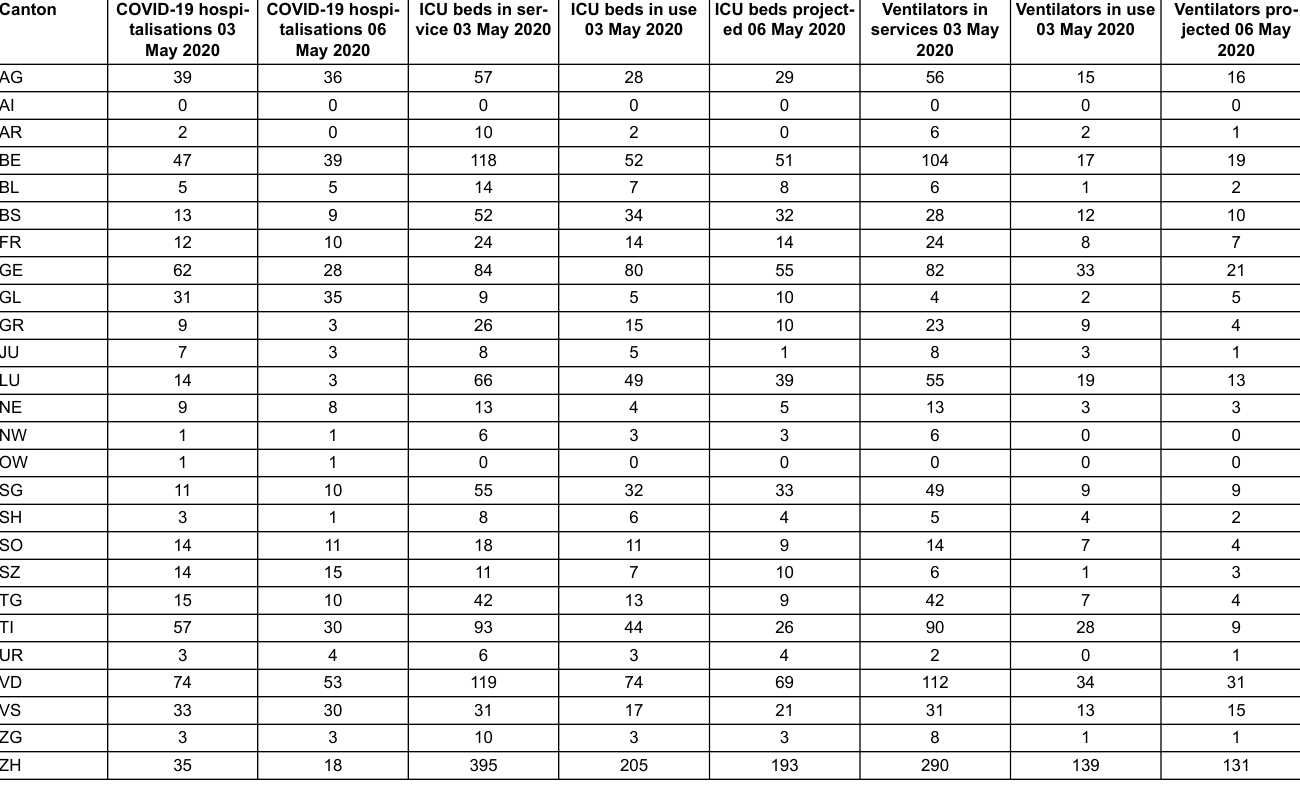
Table 4: Observed and projected numbers for hospitalisations, ICU bed usage and ventilator use, by canton. Canton COVID-19 hospi- talisations